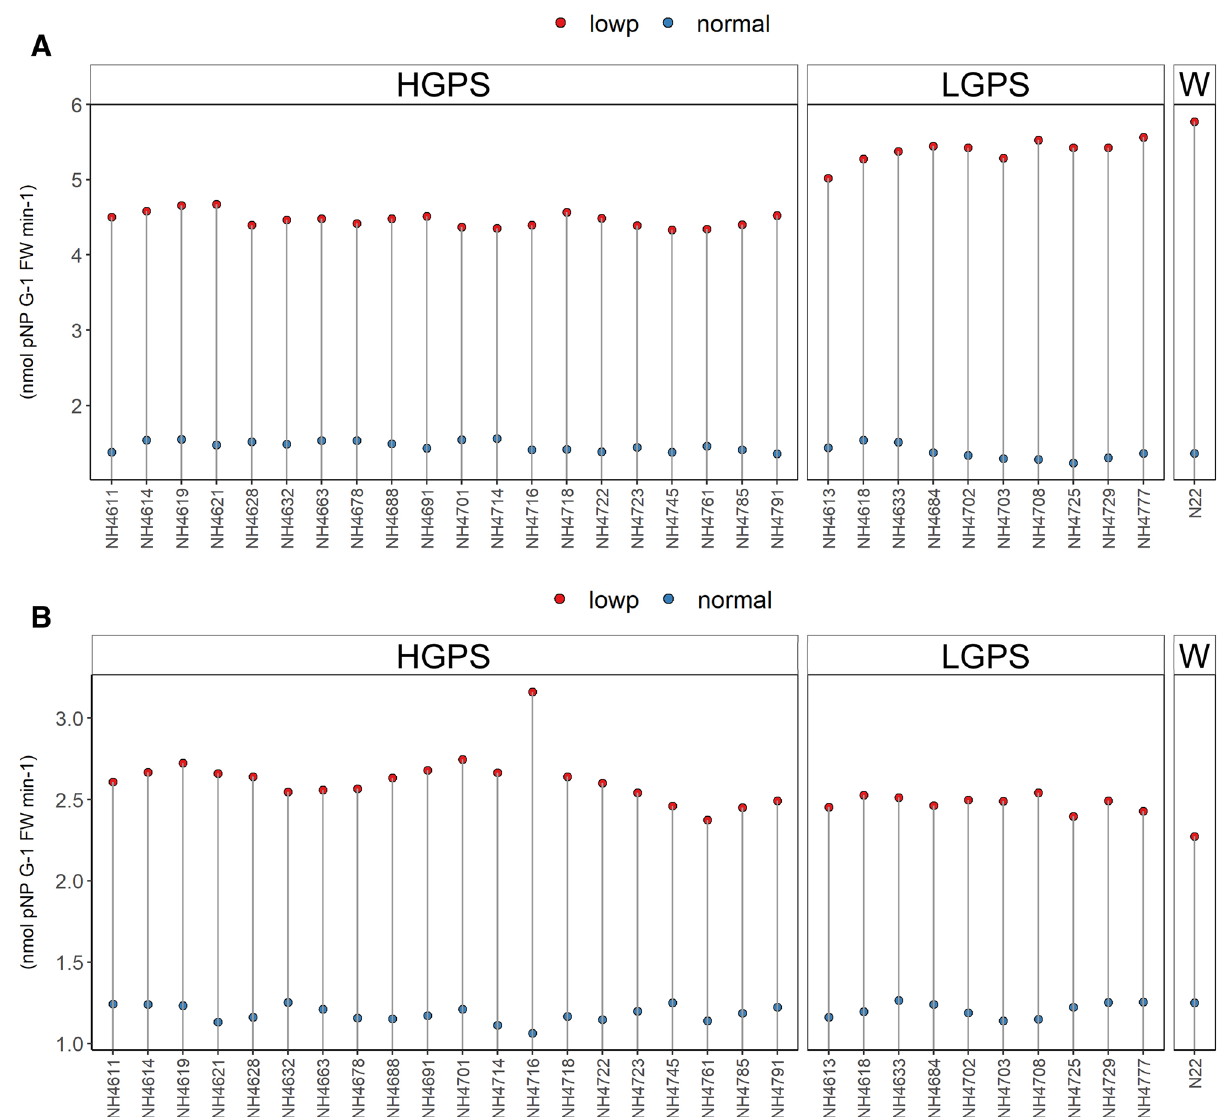
Figure 13. Root acid phosphatase (RApase) enzyme activity of seedlings obtained from germination of seeds harvested from low P (shown as red dots) and normal P (shown as blue dots) fields. Wild type N22 (W), high grain P mutant seedlings (HGPS), and low grain P mutant seedlings (LGPS) were grown under normal P condition. ( A ) RApase enzyme activity at 12 days of germination. ( B ) RApase enzyme activity at 24 days of germination. The values represent the mean of 6